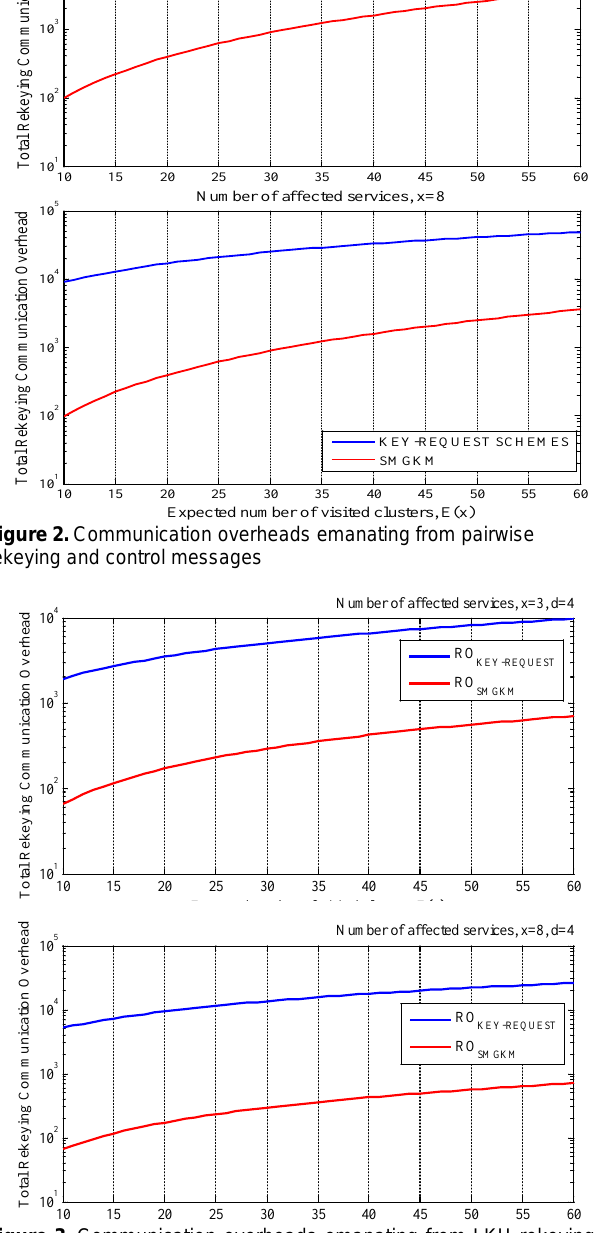
Figure 3. Communication overheads emanating from LKH rekeying and control messages